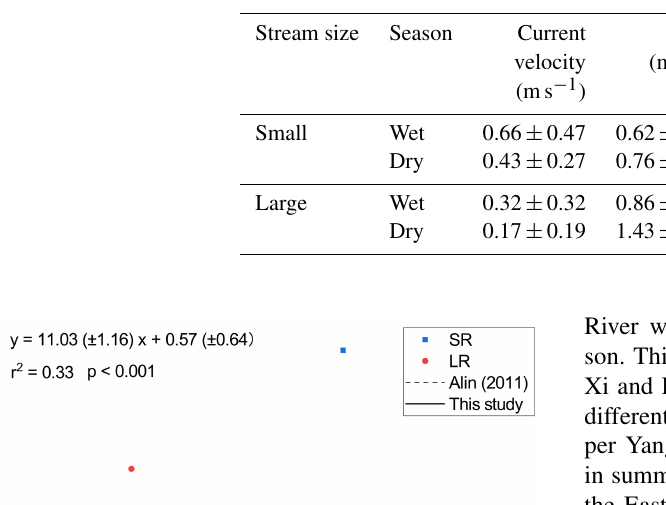
Table 2. Seasonal variation in k 600 and environmental factors in small and large rivers.